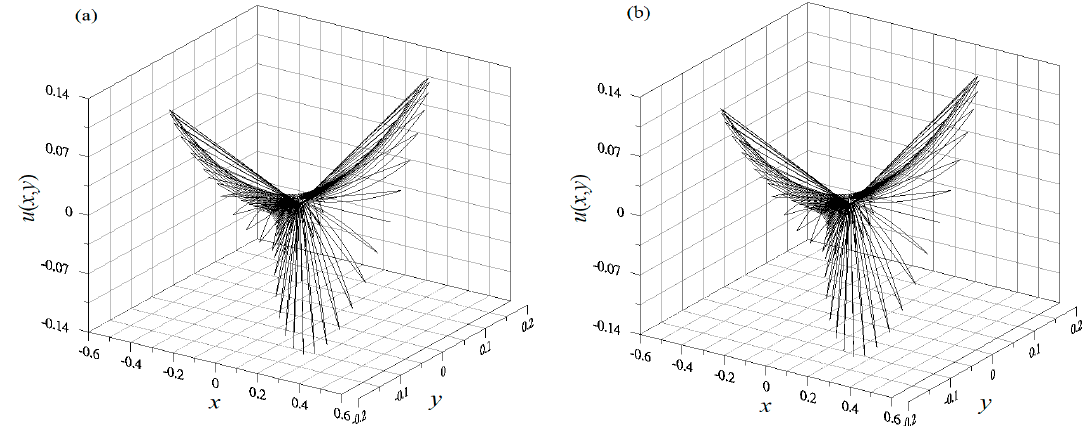
Figure 12. The exact solutions for the steady-state AC equation with peanut-shaped domain are shown in ( a ), and in ( b ) the proposed approach solution without random noise.